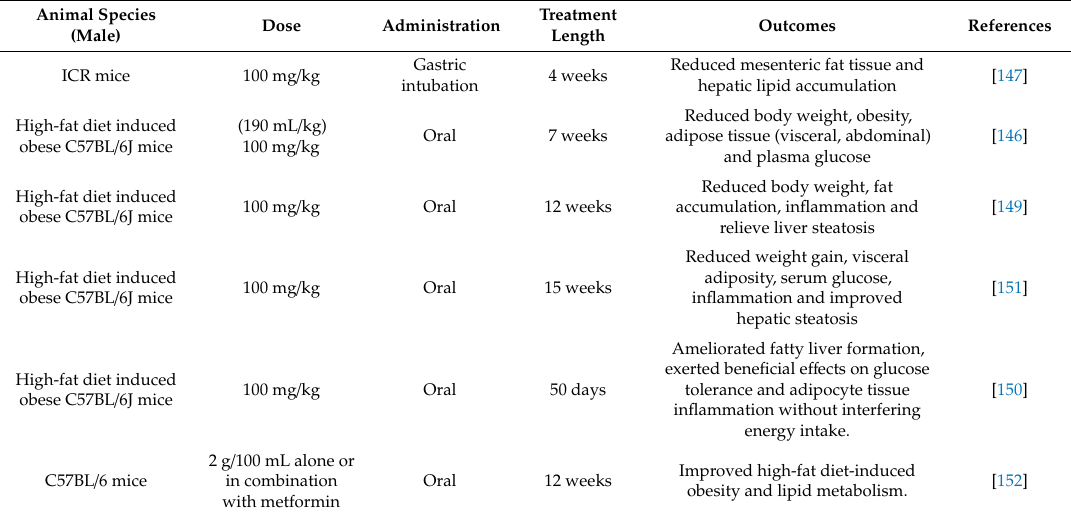
Table 2. Impact of bLf on the metabolic syndrome components or obesity: Preclinical studies. Animal Species Dose (Male)